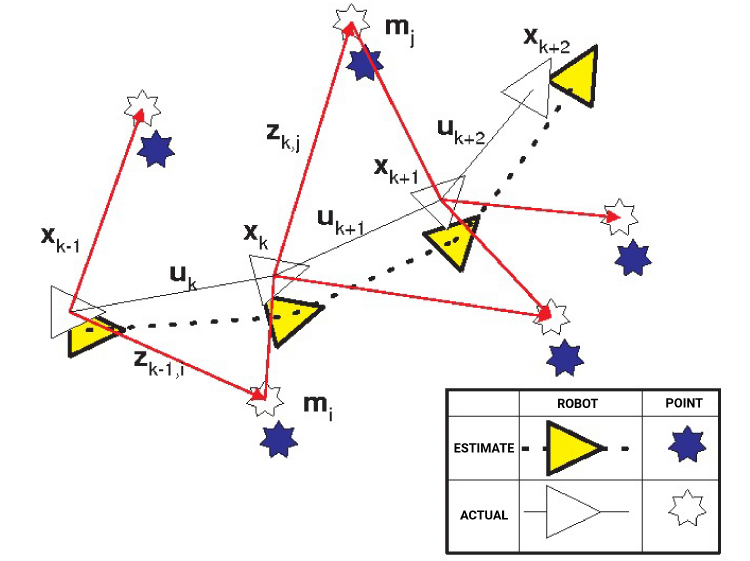
Figure 1. A picture of a